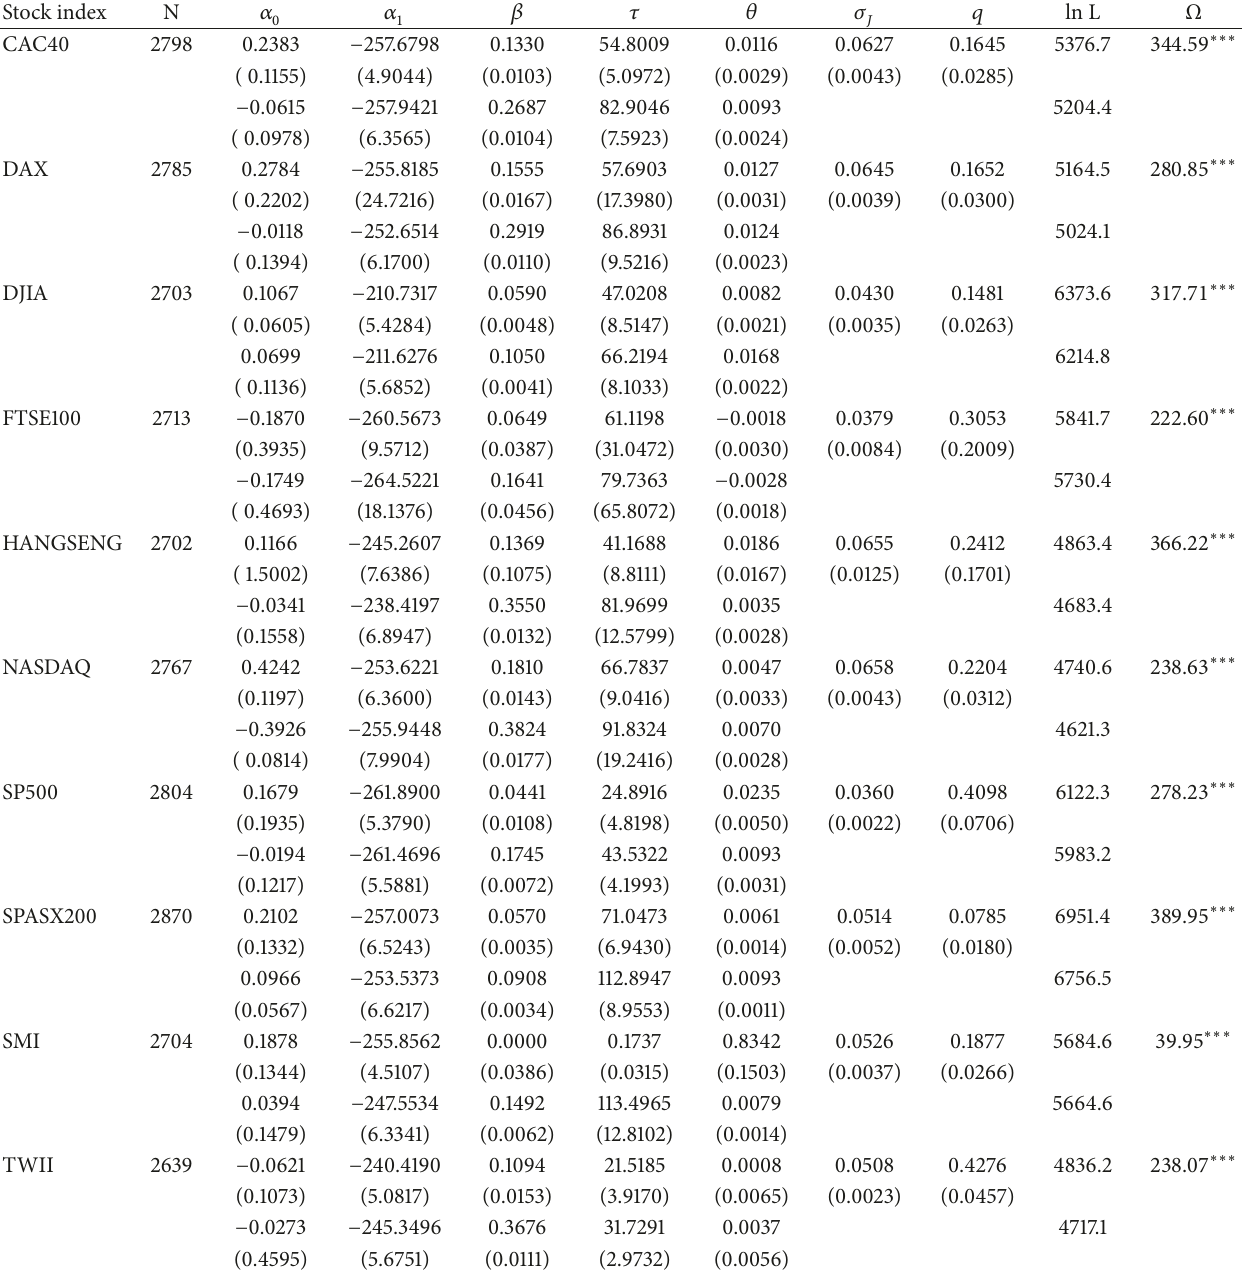
Table 4: Parameter estimates for stock